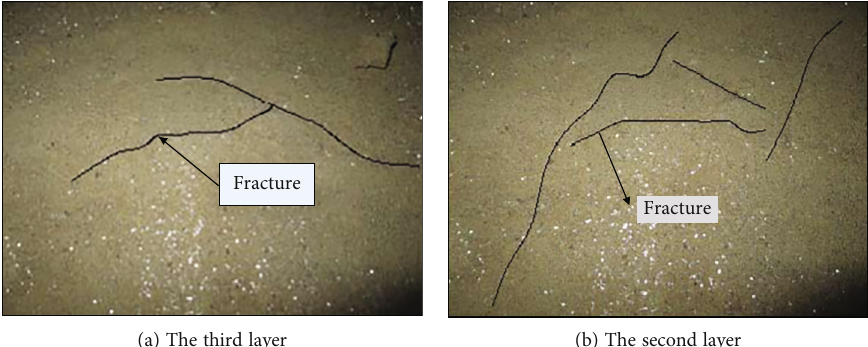
Figure 20: Crack growth and expansion.